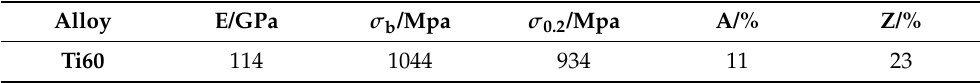
Figure 2. ( a ) Metallographic microstructure; ( b ) the high-magnification photograph of microstructure, α s + β indicates the secondary α phase distributed in β phase. Table 2. The physical properties of Ti60